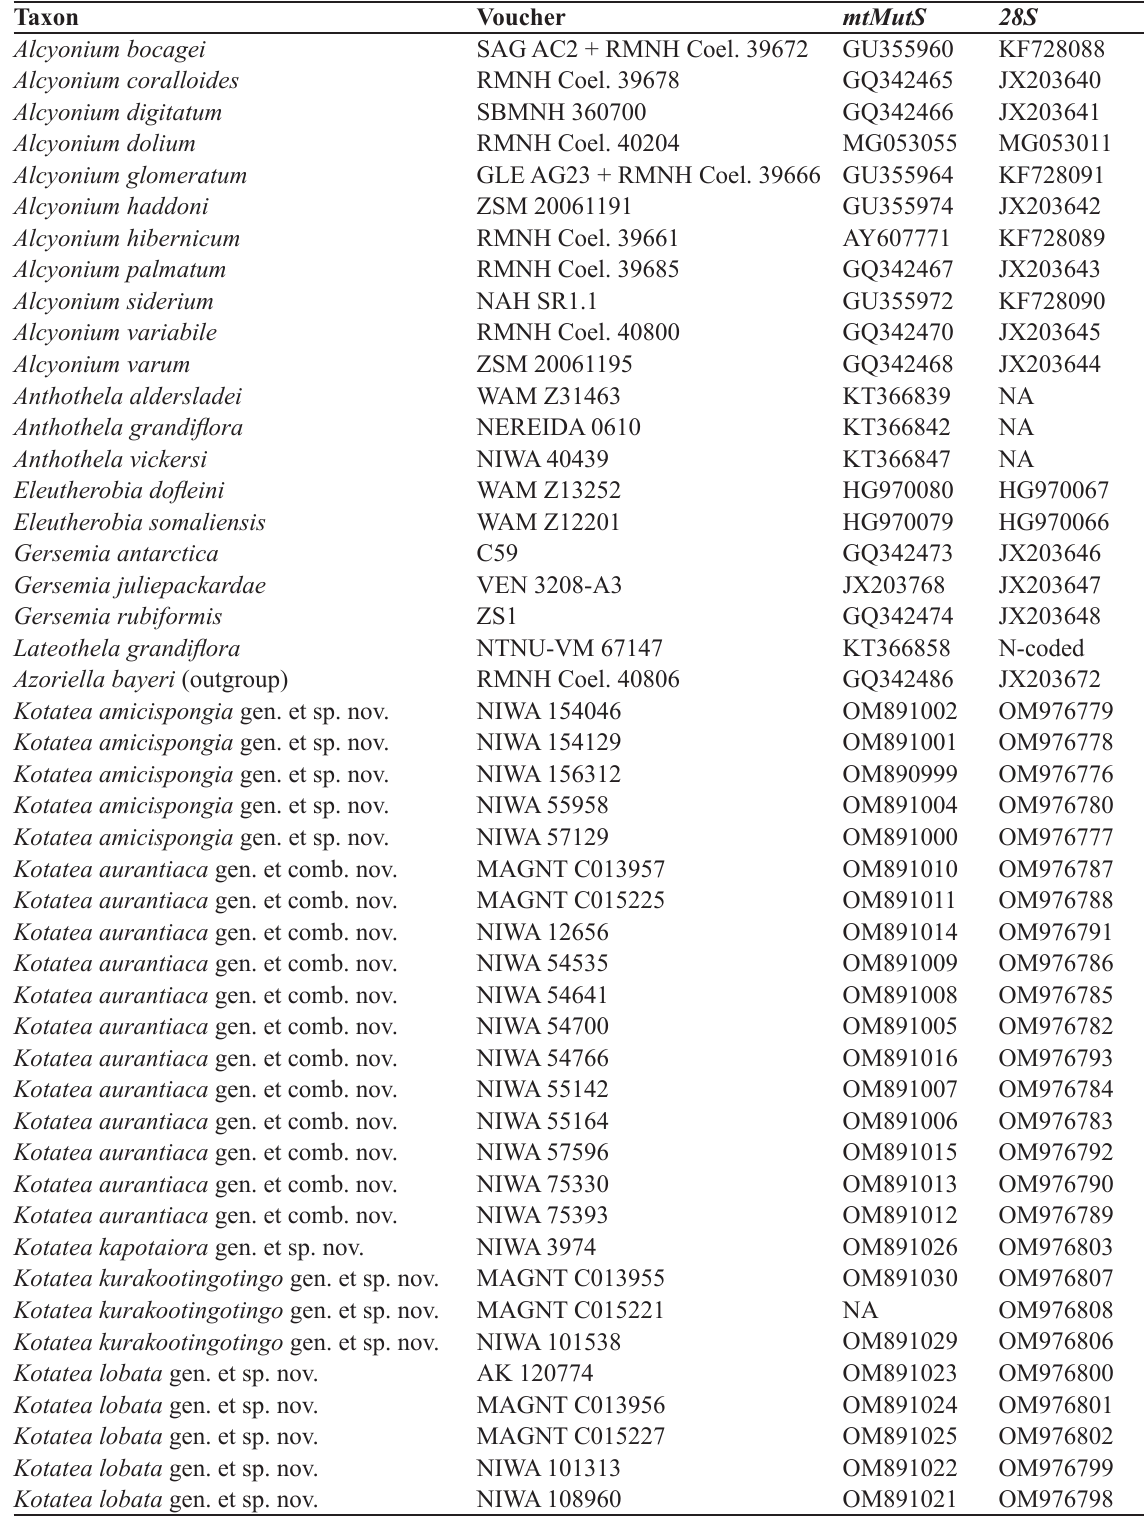
Table 2 (continued on next page). GenBank accession numbers for sequences used in phylogenetic analyses. A ‘+’ in the voucher column indicates that sequences originating from two different voucher specimens were